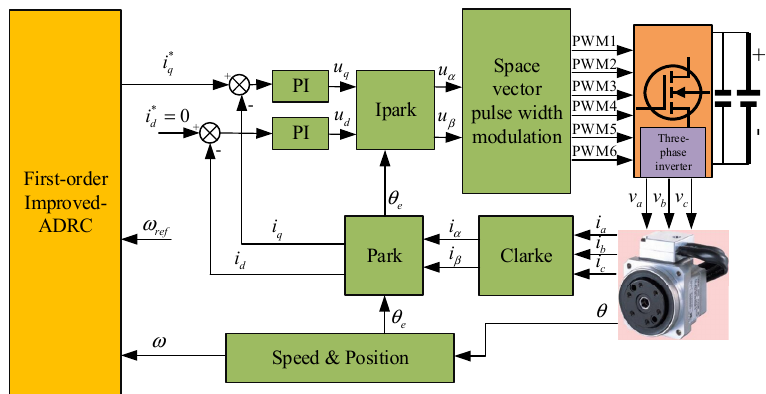
Figure 3. Block diagram of the I-ADRC structure.